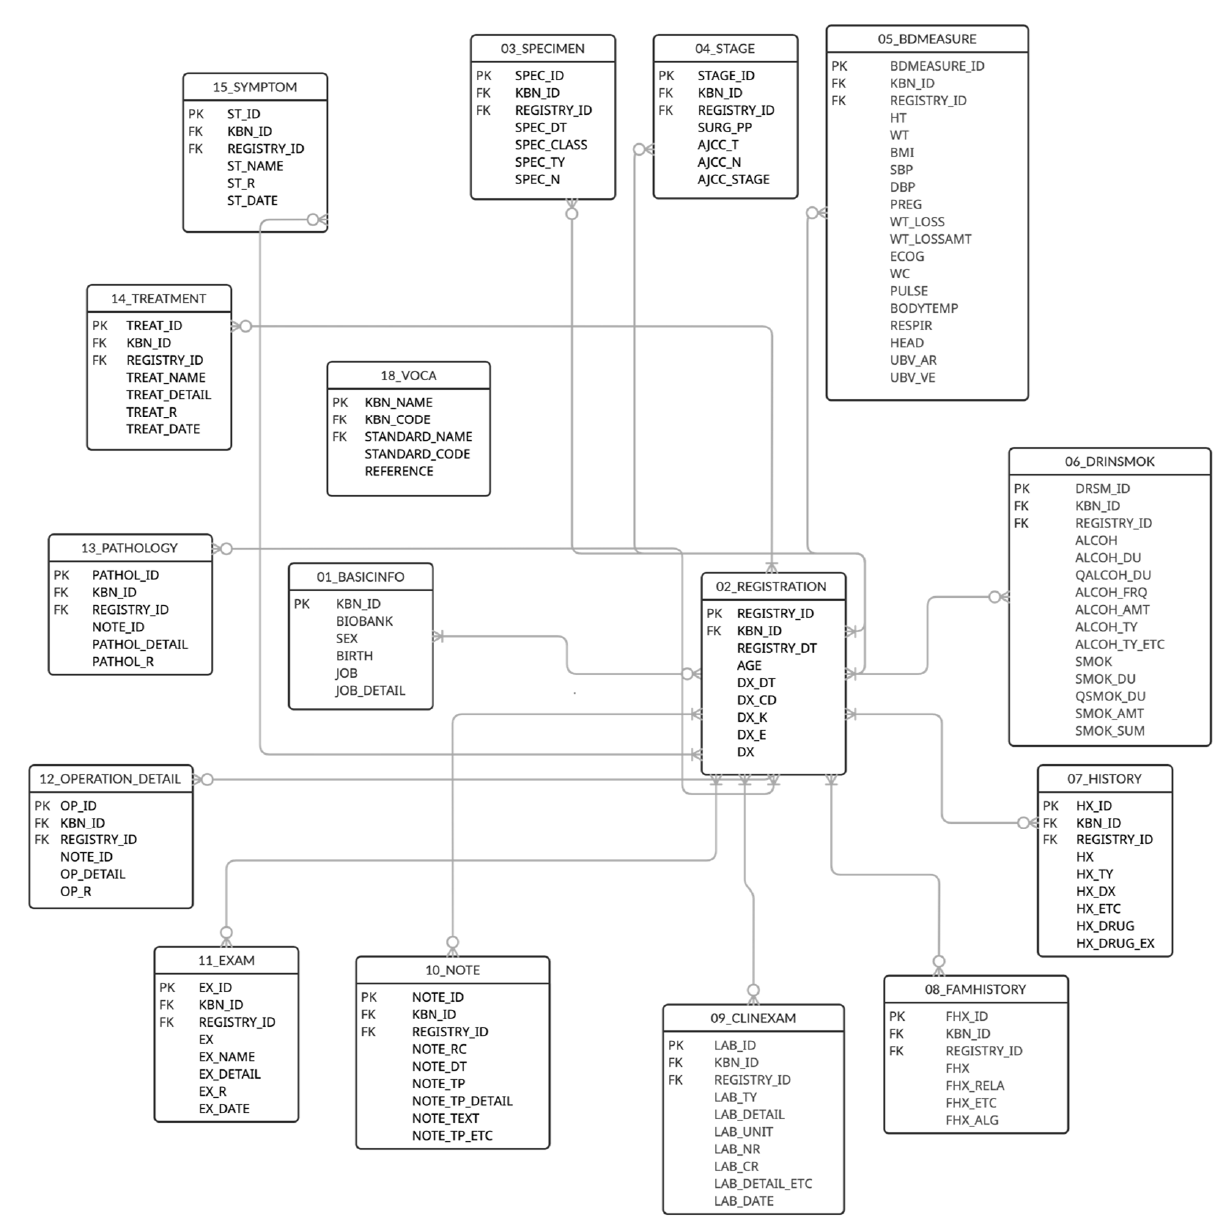
Figure 1. KBN clinical CDM unified modeling language.